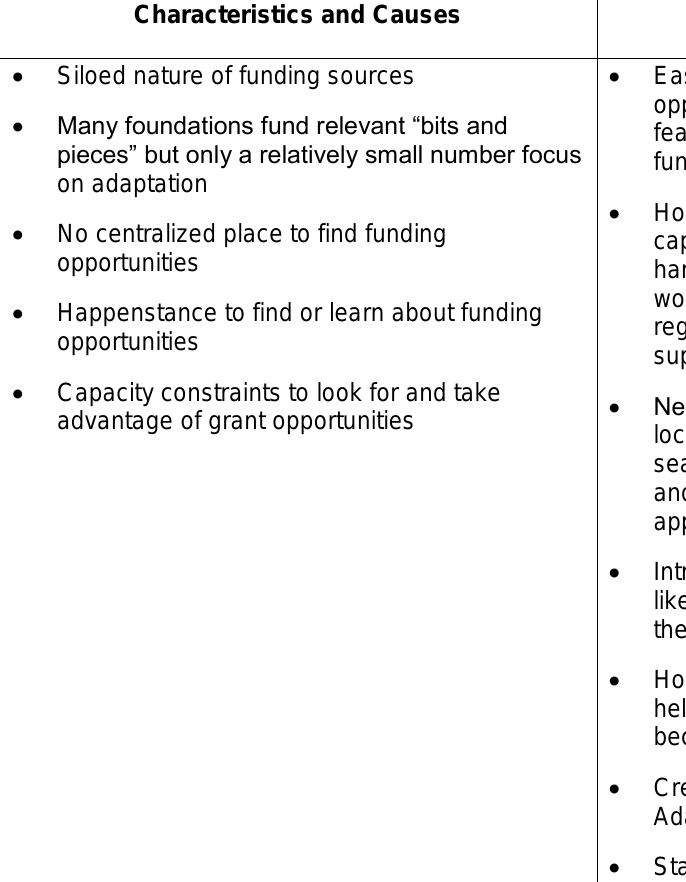
Table A2.14: Characteristics, Underlying Causes and Potential Solutions to